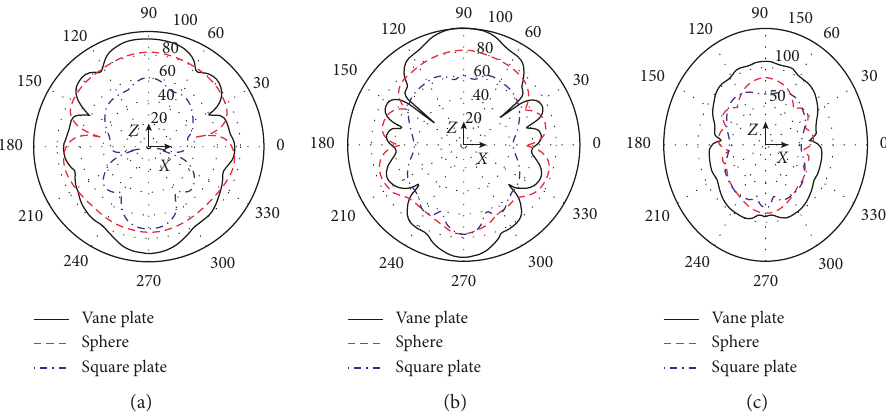
Figure 5: Sound pressure level characteristic curves of three different shape markers under typical frequency sound waves: (a) 7kHz frequency sound wave, (b) 10kHz frequency sound wave, and (c) 14kHz frequency sound wave.